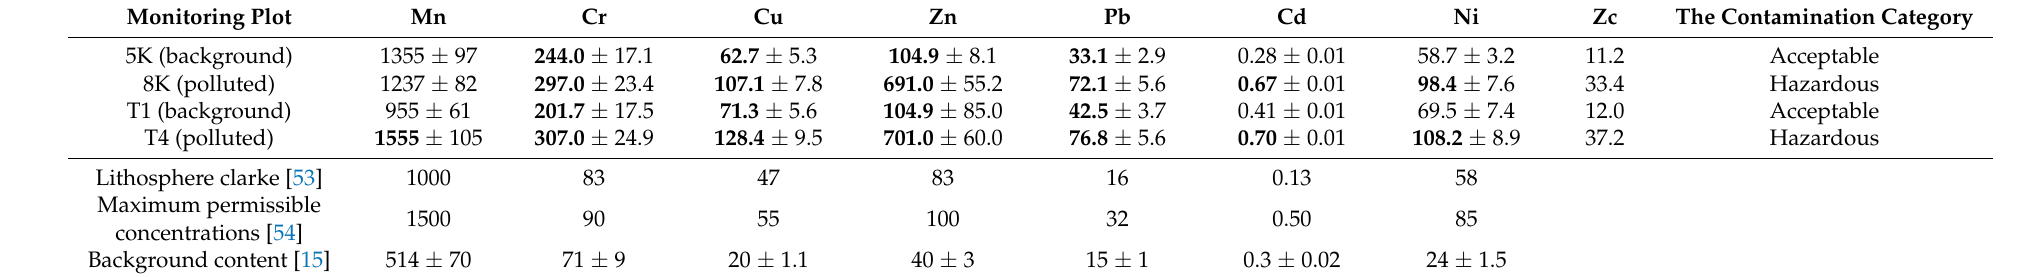
Table 1. Total content of Mn, Cr, Cu, Zn, Pb, Cd and Ni (mg/kg) at the 0–20 cm layer of fluvisols at monitoring plots in the Don River